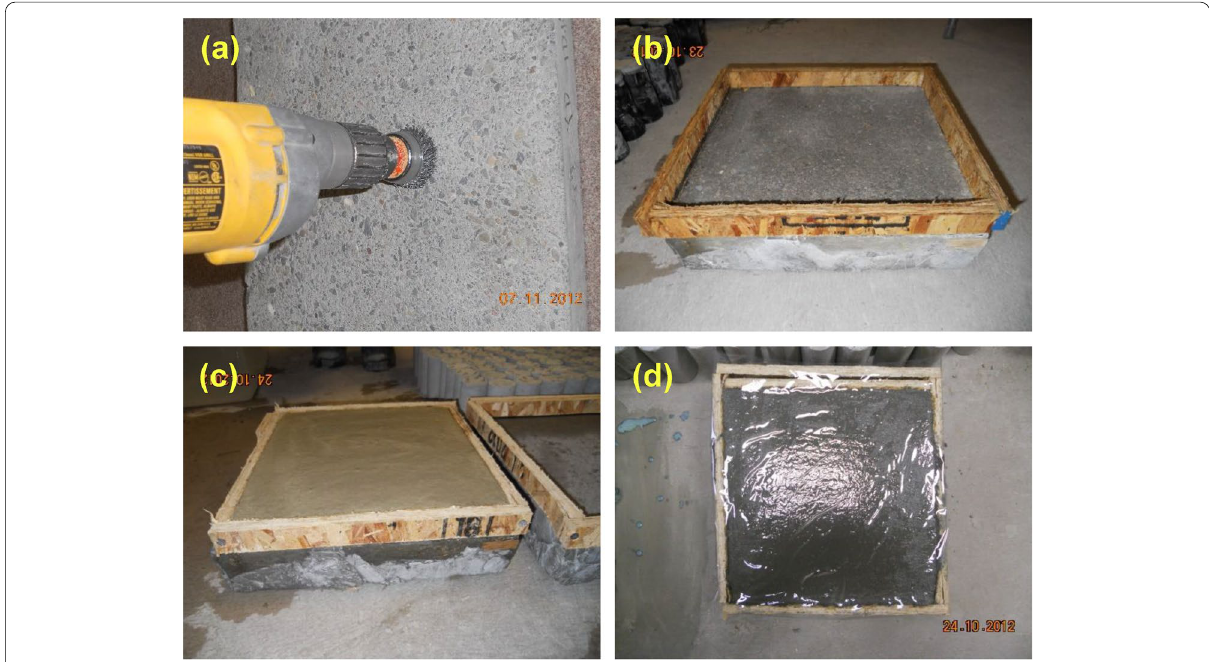
Fig. 1 Preparation of the cement-based overlays: a Brushing the surface of concrete slab; b Installing the framework and wetting the concrete slab; c Casting the cement-based overlays, and d Curing